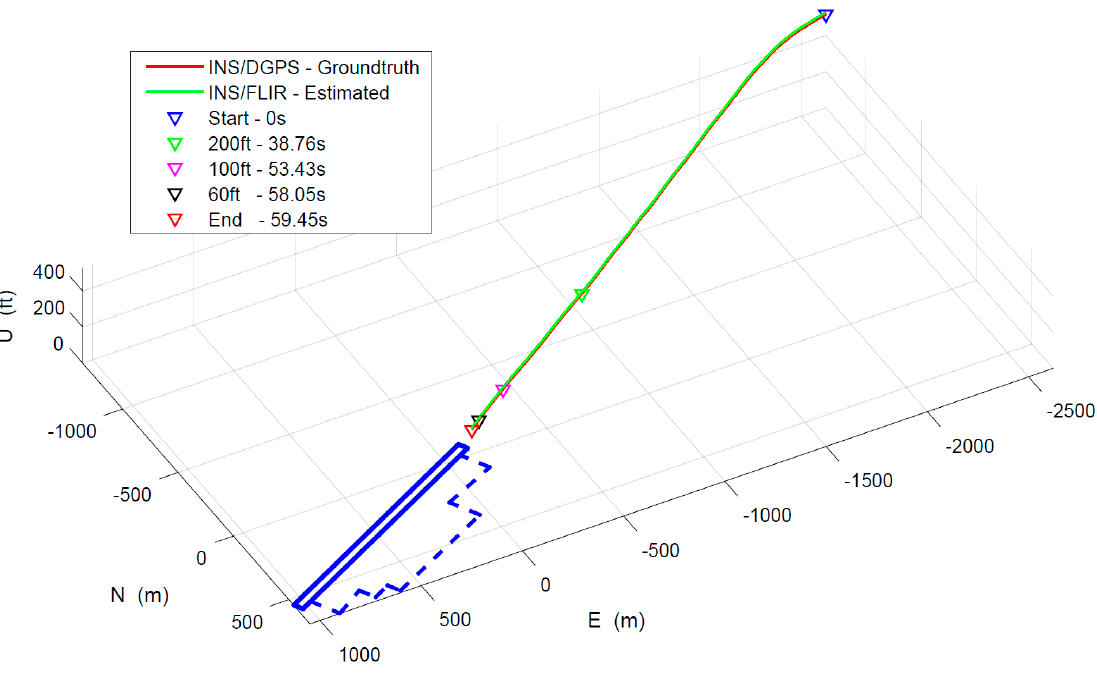
Figure 11. Approach and landing trajectory.